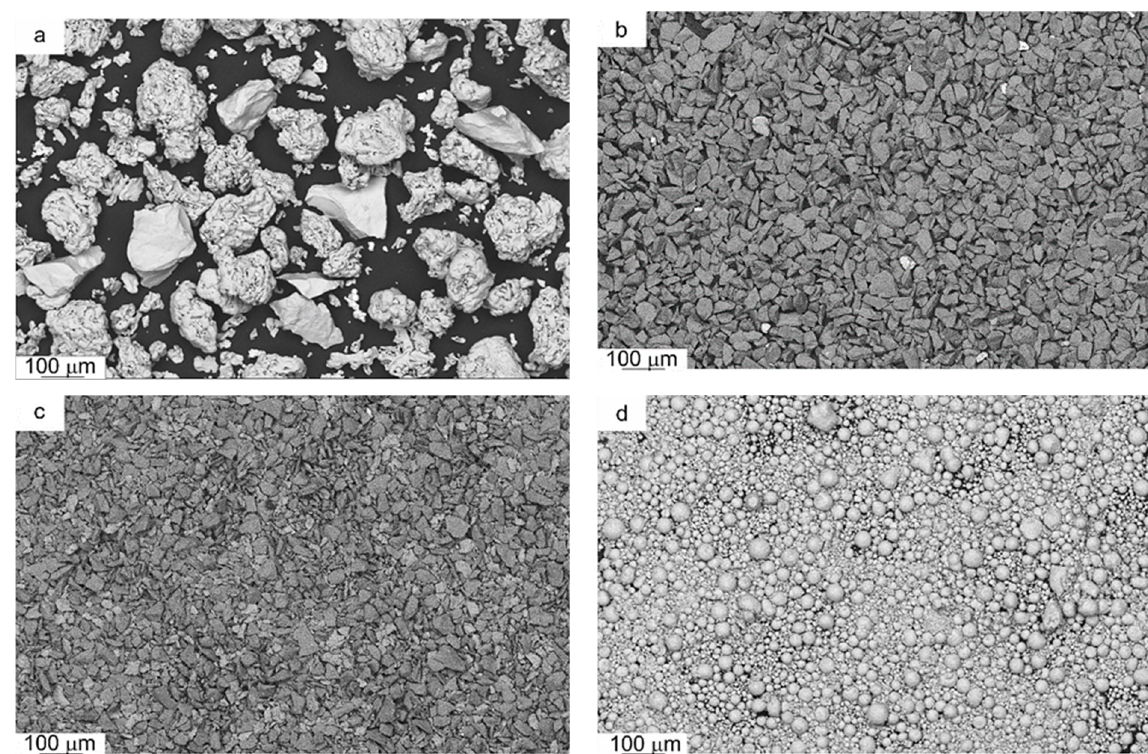
Figure 1. SEM images of the starting powders: ( a ) Fe–Mn–Cu–Sn–C mixture powders; ( b ) SiC; ( c ) Al 2 O 3 ; ( d ) ZrO 2 .